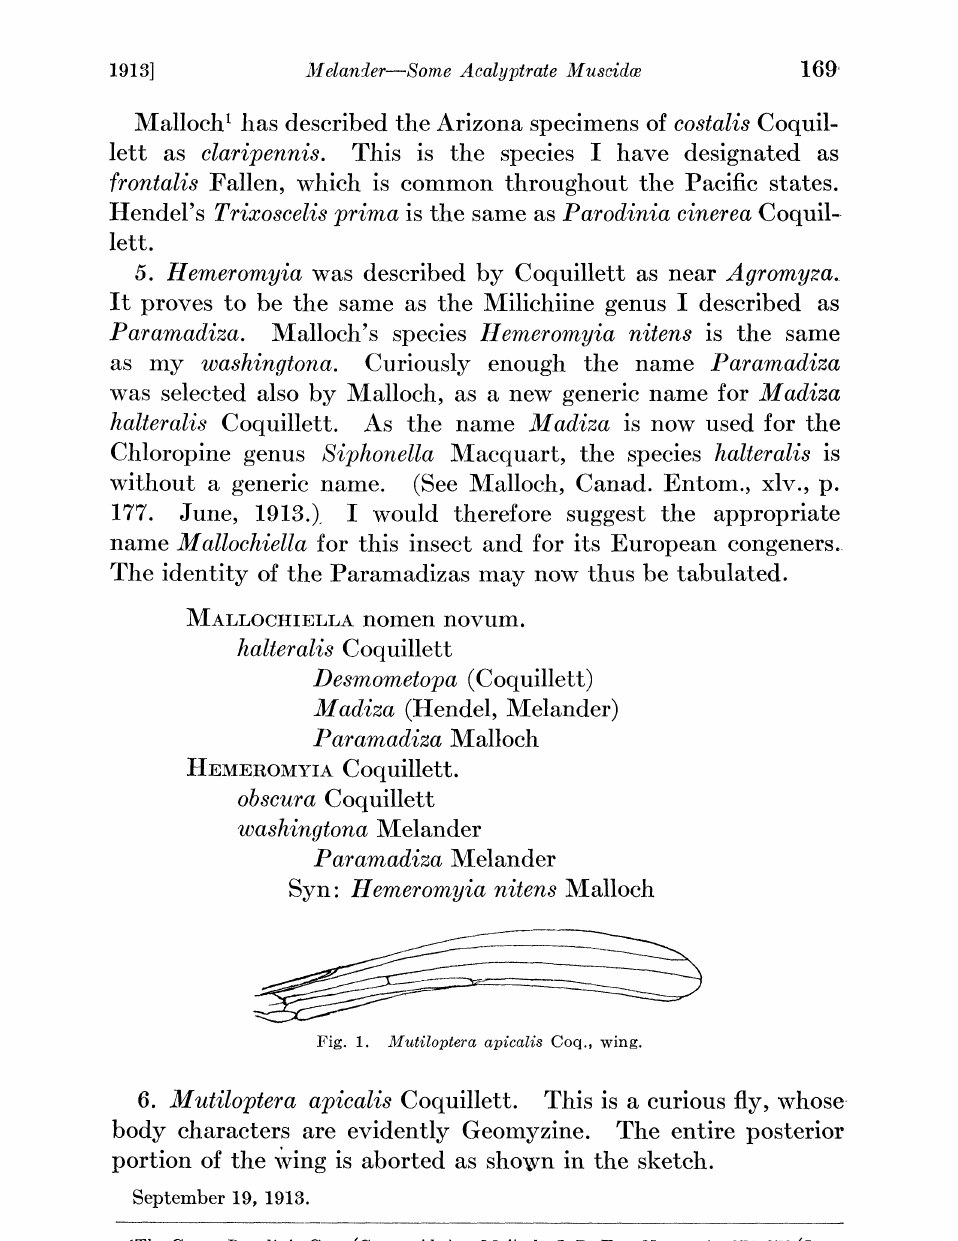
Fig. 1. Mutiloptera apicalis Coq., wing. 6. Mutiloptera apicalis Coquillett. This is a curious fly,